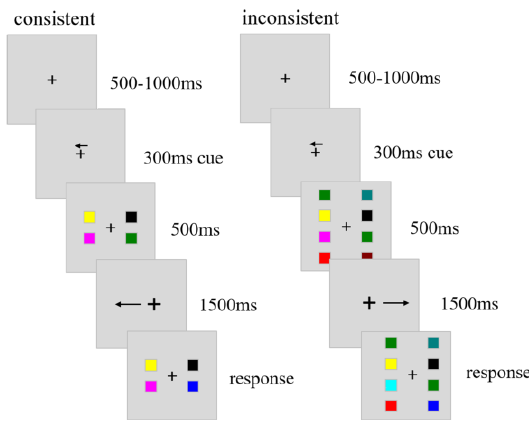
Figure 1. Schematic representation of stimuli sequence in the WM + pursuit session. The cue pointed to the left and right before the onset of the target stimuli, which consisted of 2 or 4 colored squares in both VFs. Subjects were required to memo- rize the color of the squares in the cued VF and judged whether the colors of the test stimuli in the cued VF were same or not. During the retention period, subjects pursued the cross which moved towards or away from the cued VF. According to the direction of the cross motion, the trials were grouped into con- sistent and inconsistent